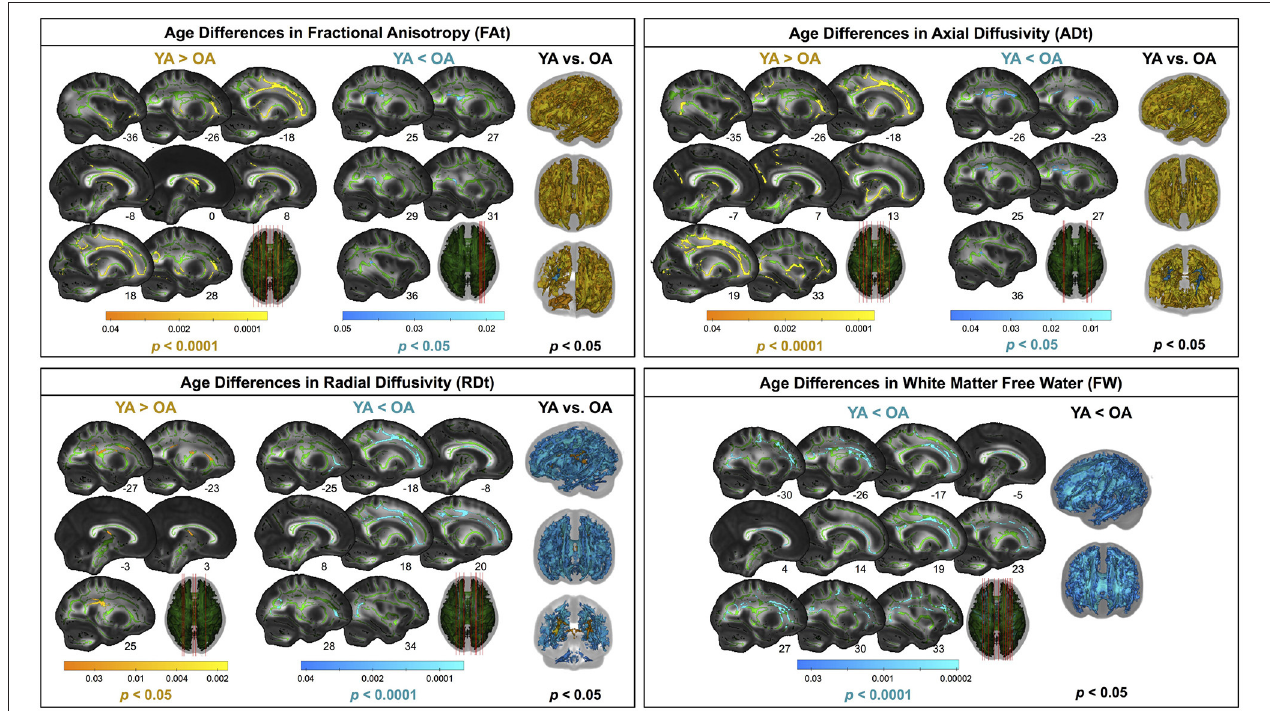
FIGURE 5 | Age differences in FW-corrected white matter microstructure. Warm colors indicate regions where young adult values were greater than older adult values. Cool colors indicate regions where young adult values were lower than older adult values. Results are shown on the FMRIB58 FA template with the group mean white matter skeleton (green) overlaid. Age differences at p FWE − corr < 0.05 covered almost the entire white matter skeleton; these results are depicted in the rightmost column of each panel. The left portion of each panel depicts more conservative statistical thresholding (noted under each colorbar) to better illustrate which regions showed the most pronounced age